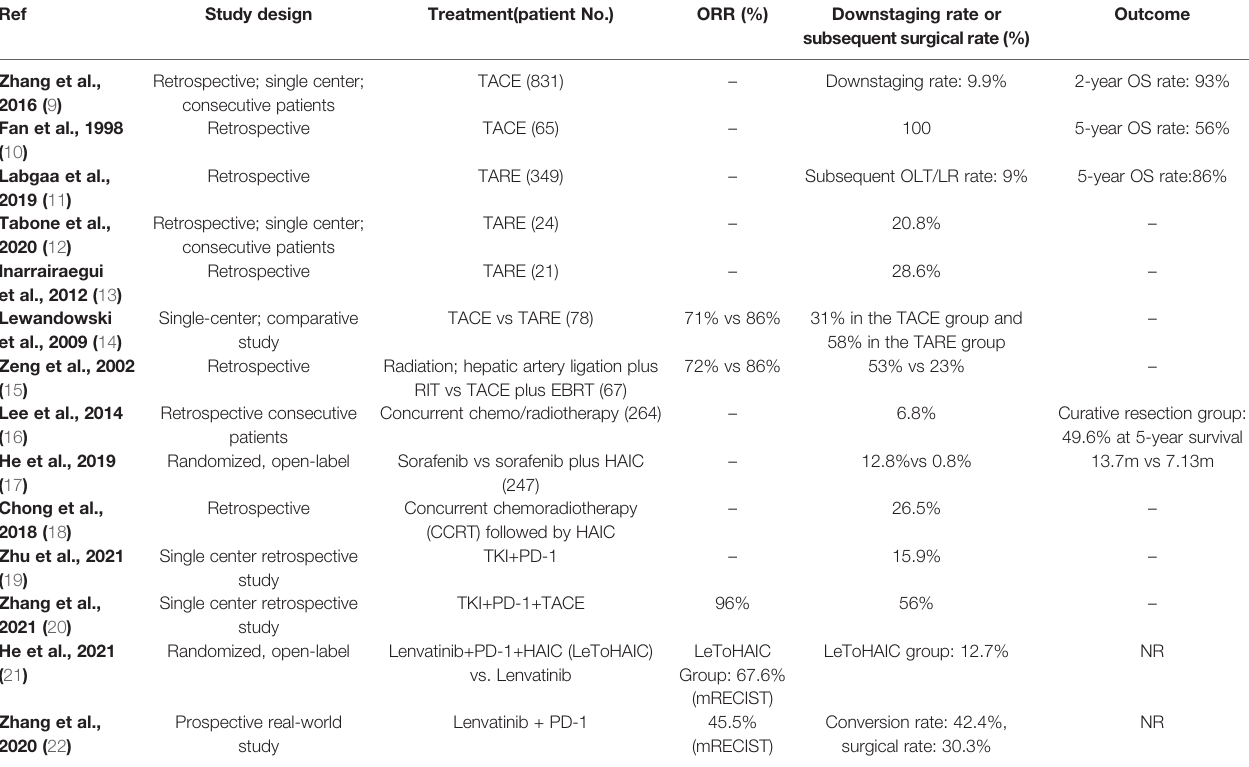
TABLE 1 | Summary of clinical evidence for tumor down-staging in patients with unresectable